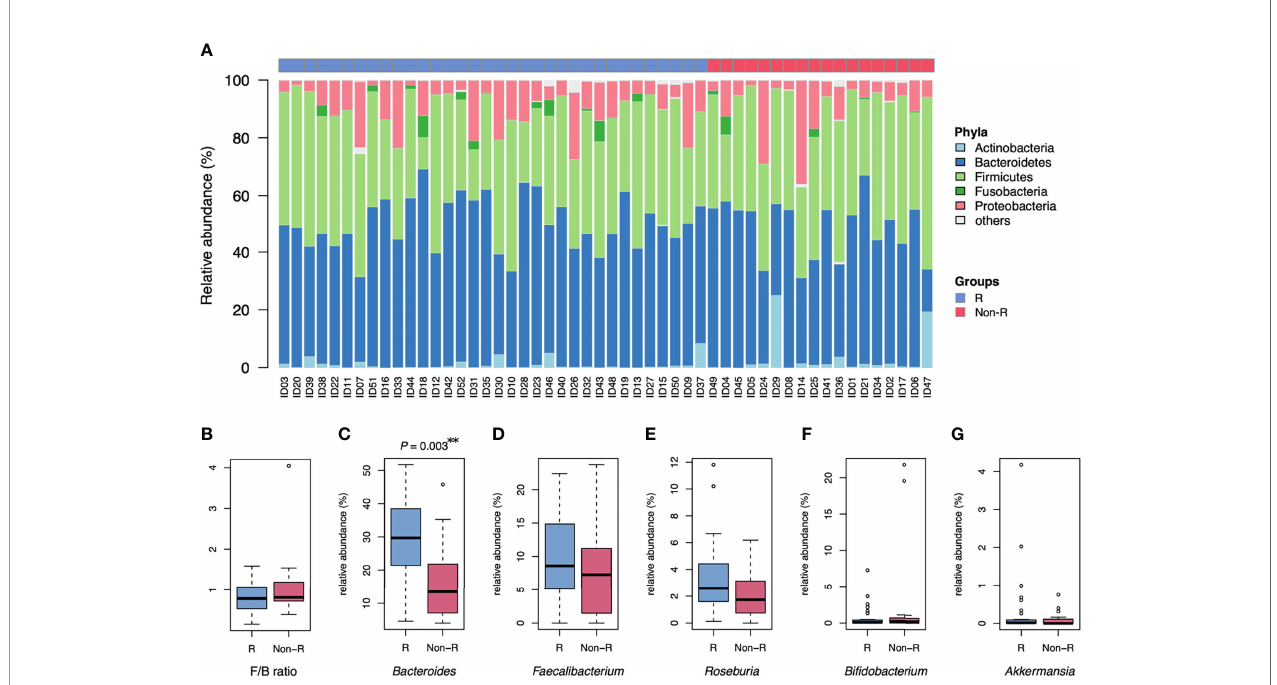
FIGURE 2 | Microbiota composition of type 2 diabetic patients receiving GLP-1 RA treatment: responders and non-responders. (A) The barplot is relative abundance of bacteria at the phylum level. Samples are in a sequence of HbA1c reduction across the x-axis. Bacteroidetes was the dominant taxa in most samples. (B) The Firmicutes/Bacteroidetes ratio (F/B) was not different between groups. (C) The relative abundance of Bacteroides was higher in responders than non- responders (** P < 0.01, Wilcoxon rank sum tests). (D, E) No signi fi cant difference in relative abundance of Faecalibacterium and Roseburia in both groups. (F, G) Bi fi dobacterium and Akkermansia were scarce in both groups. Groups are responders (R) and non-responders (Non-R). HbA1c,